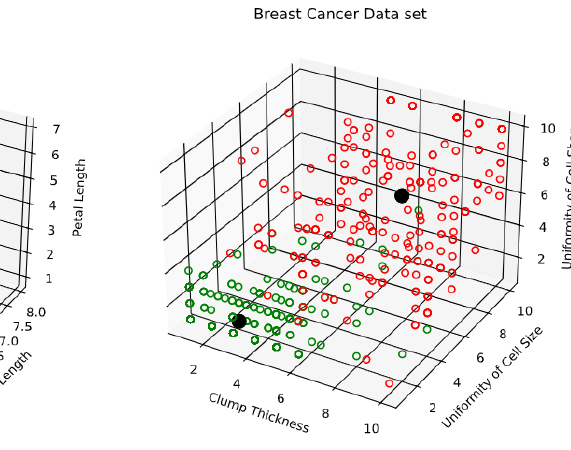
Figure 12. Accuracy using FCM on the experimental data sets.